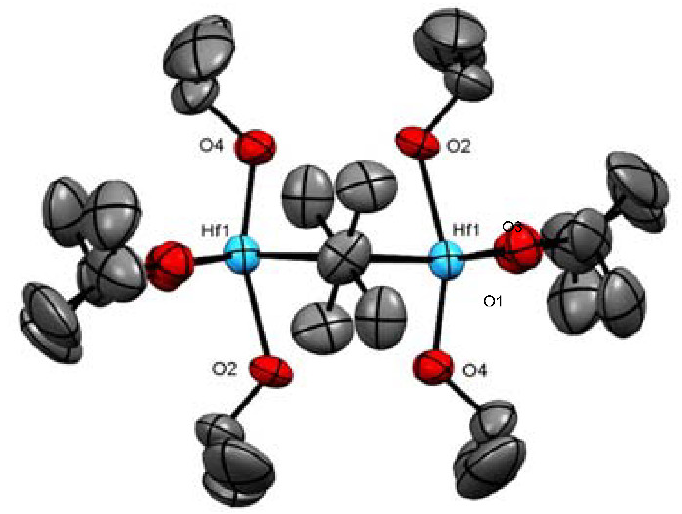
Figure 9. ORTEP drawing of 8 [Hf 2 (O i Pr) 8 · ( i PrOH) 2 ]. Hydrogen atoms are omitted for clarity.